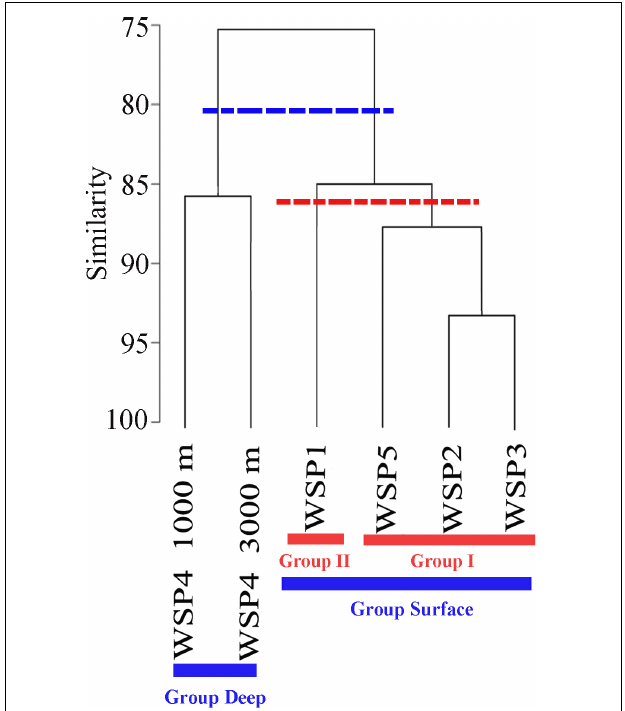
FIGURE 2 | Community similarities among the samples based on the UPGMA clustering with the abundance of 16S OTUs. The cluster dendrograms were constructed based on Bray–Curtis similarity using